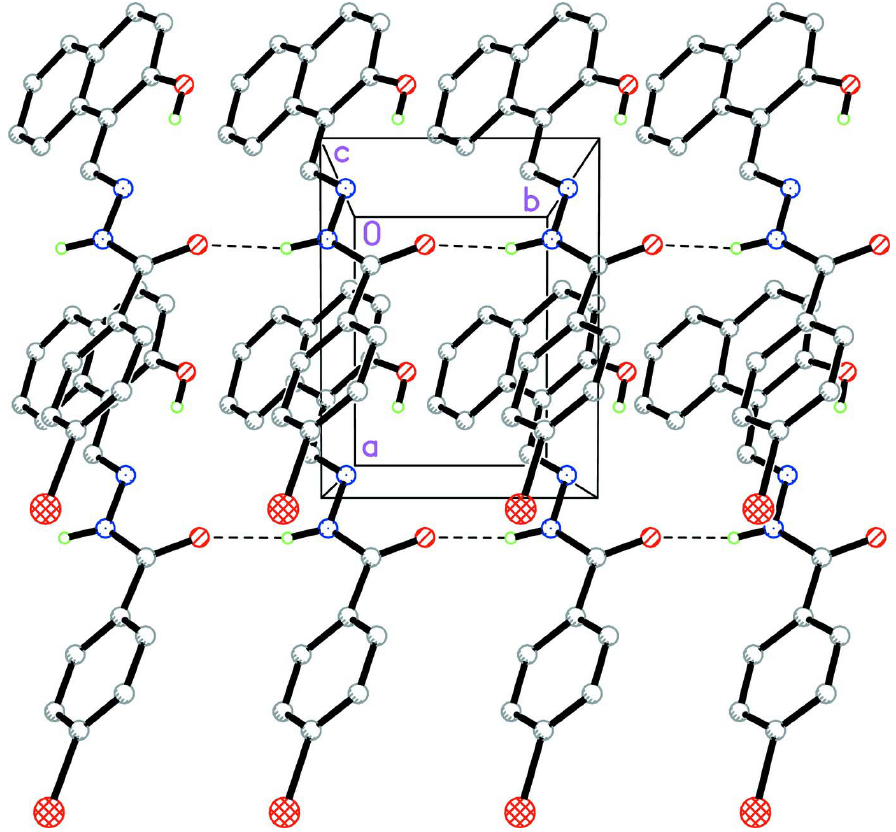
Figure 2 A persepctive view along the a axis of the crystal packing of the title